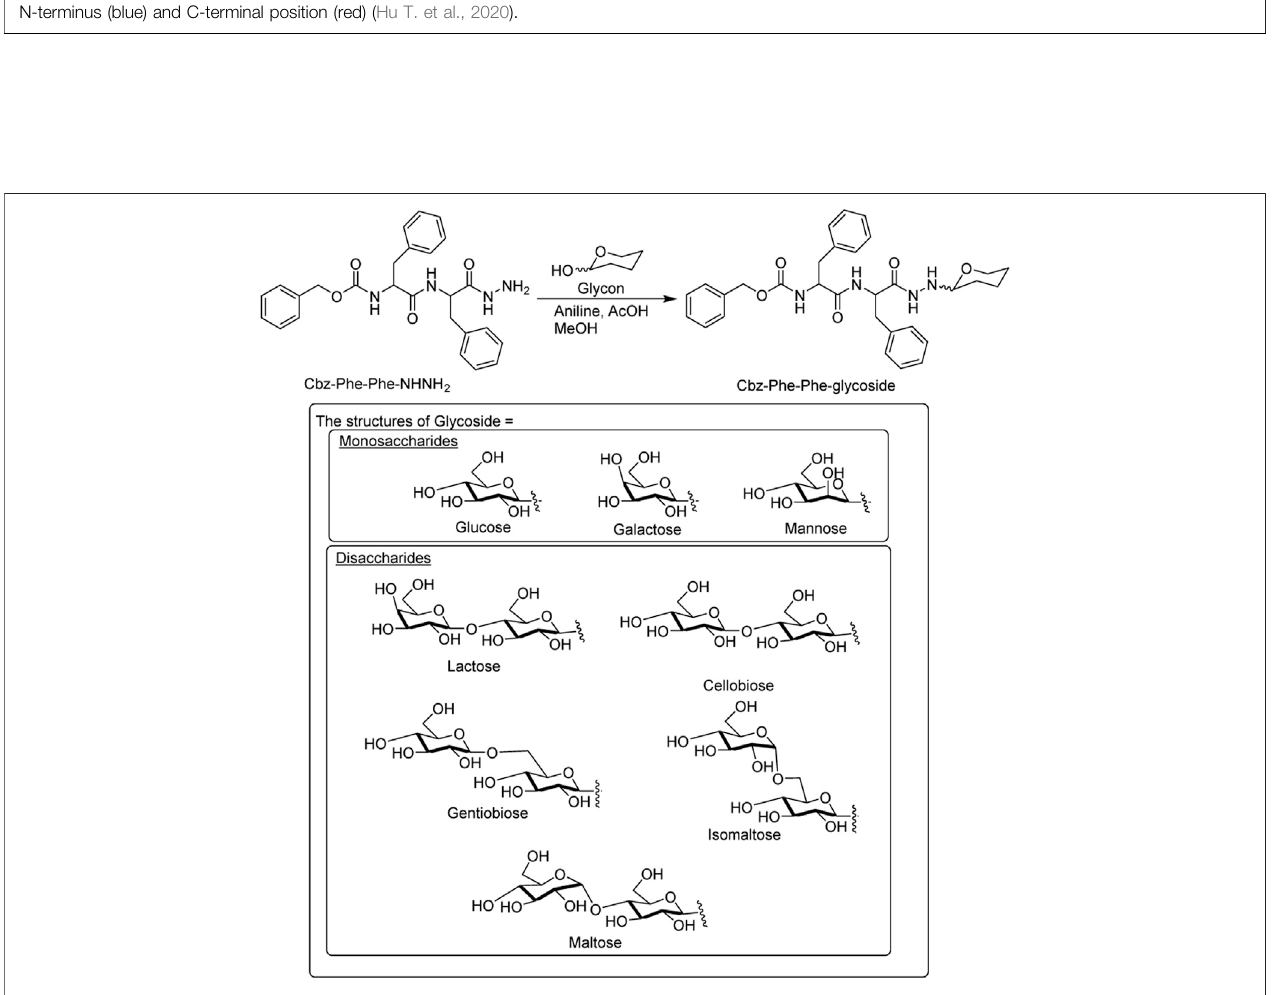
FIGURE 9 | The structures of C-terminal modi fi ed dipeptides by Ikeda et al.